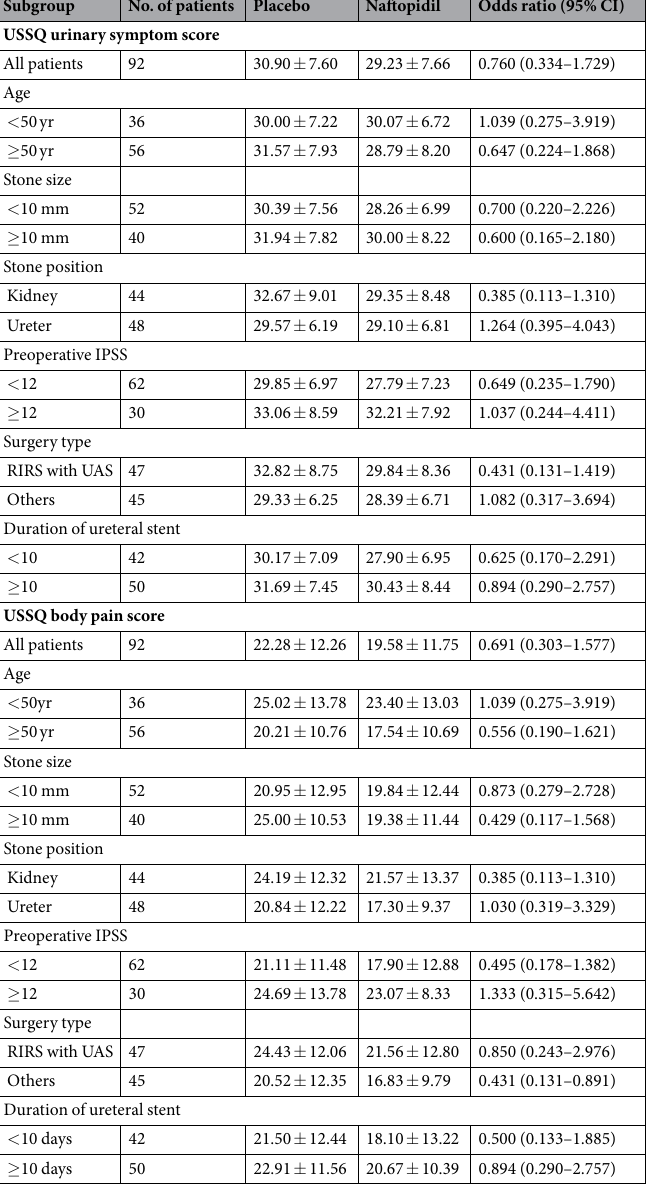
Table 4. Subgroup Analyses of odds Ratios for ureteral stent related urinary symtoms (USSQ urinary symptom score) and ureteral stent related pain (USSQ-body pain score) in the two Groups. USSQ, Ureteral stent symptom questionnaire; IPSS, international prostate symptom score; RIRS, retrograde intrarenal surgery; UAS, ureteral access